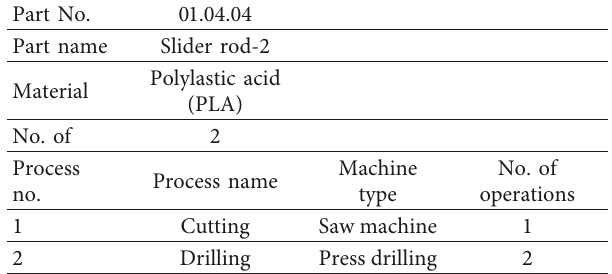
Table 14: Connecting slider